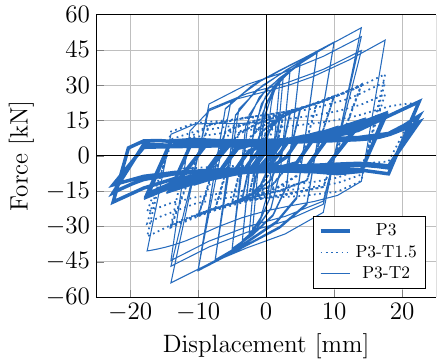
Figure 12. Hysteresis curves of P3 (original design), P3-T1.5 and